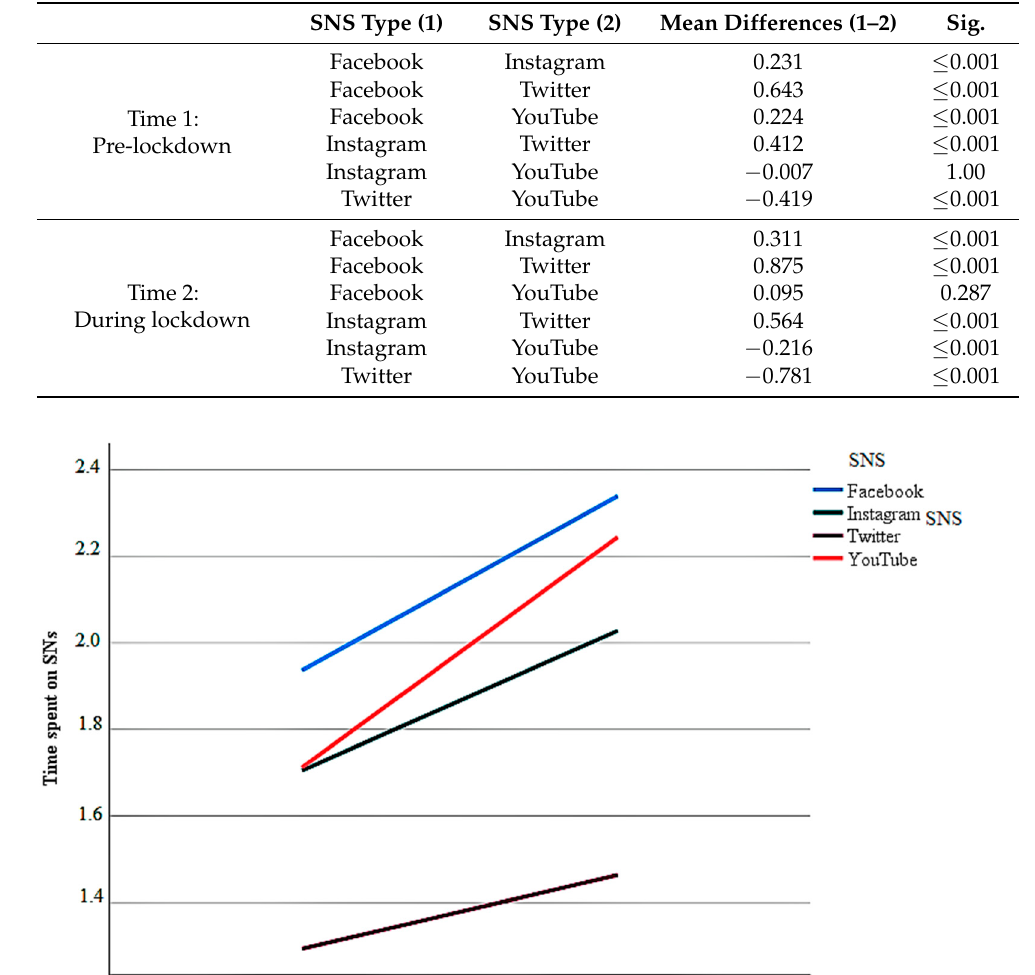
Table 2. Pairwise Comparisons Depending on the Type of SNS Used at Pre-Lockdown and During Lockdown.